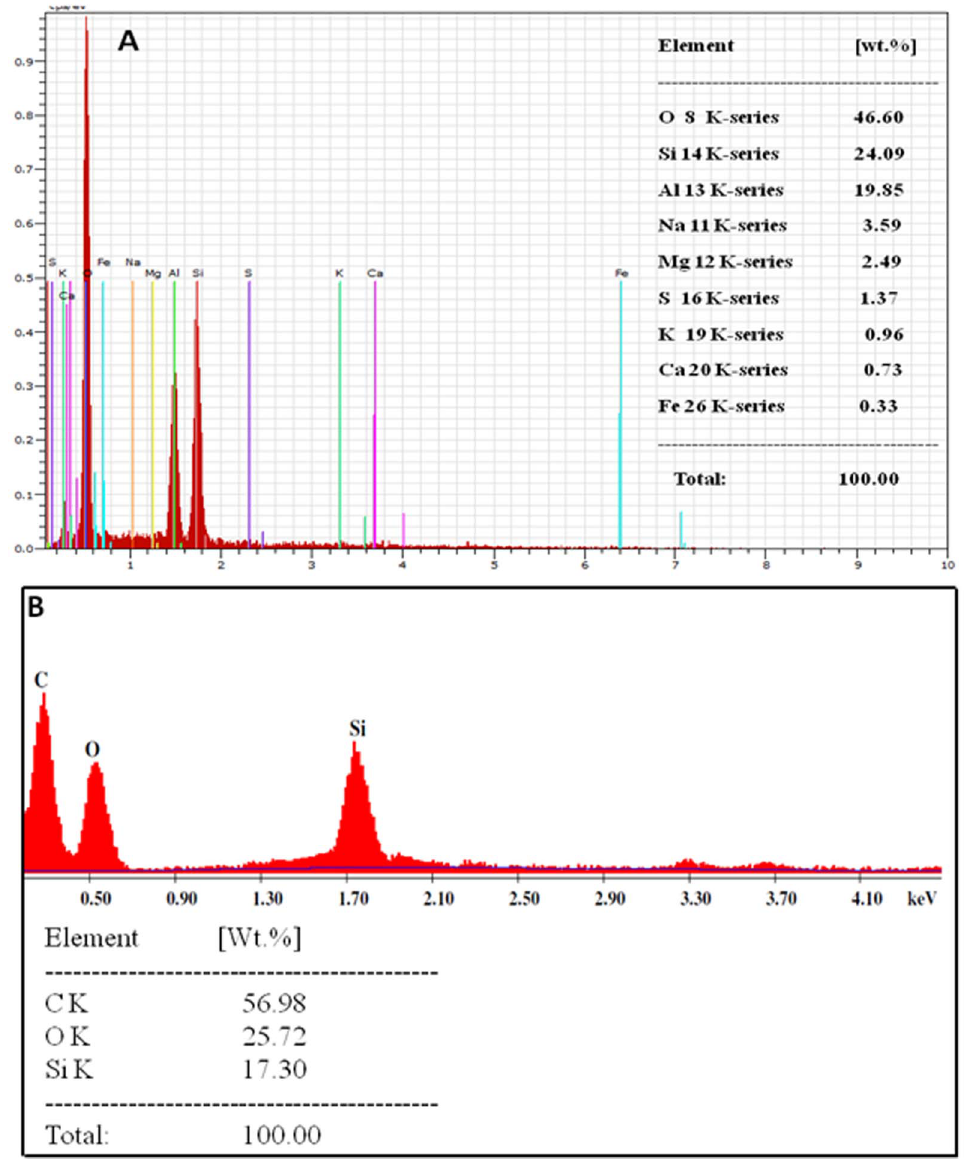
Figure 6. Energy Dispersive Analysis of X-rays (EDAX) spectrum and wieght percentages of Fly-ash powder(A) and bioleached silica nanoparticles obtained after reacting Fly-ash with Fusariumoxysporum for 24